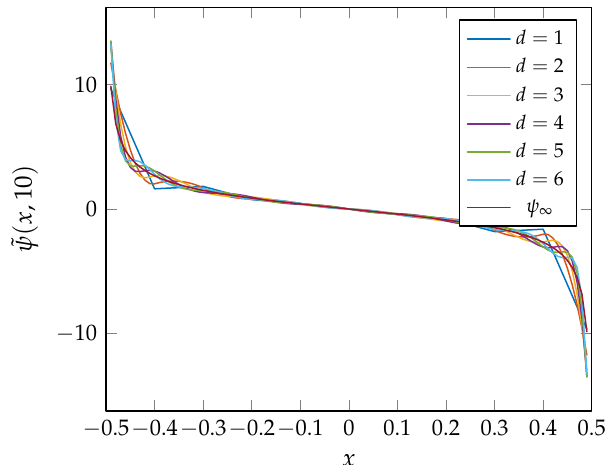
Figure 4. Densities ˜ ψ ( x ,10 ) , for growing values of degree d of the B-spline basis, compared to the stationary solution ψ ∞ ( x )